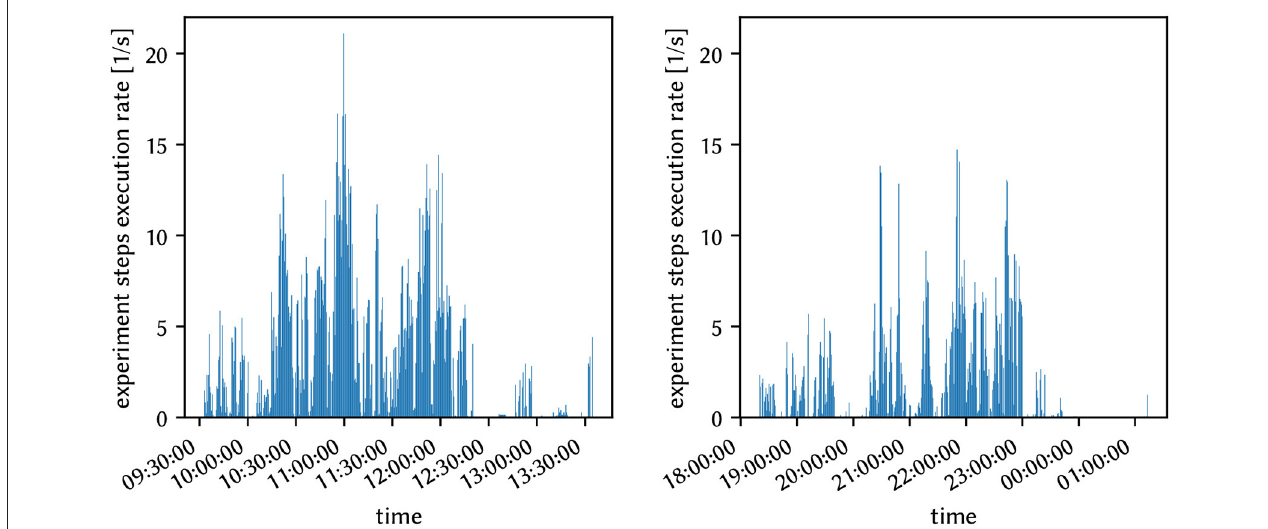
FIGURE 14 | Rate of executed experiment-steps via quiggeldy during the two BSS-2 hands-on tutorials at NICE 2021. Experiments were distributed among eight hardware setups. In total there were 86,077 hardware runs